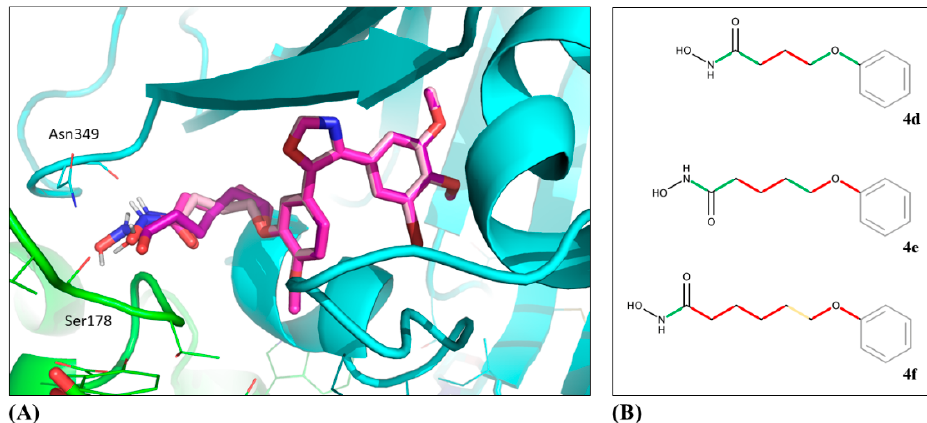
Figure 8. ( A ) Superposition of selected binding poses for 4d (light-pink), 4e (medium-pink) and 4f (dark-pink) in tubulin structure 5LYJ, exported from SeeSAR and visualized with PyMOL. ( B ) Illustration of frequent (green), occasional (yellow), and rare (red) torsions within the linker and hydroxamic acid group. Table 4. SeeSAR Docking results including estimated affinities (EA) and hydrogen bonds for Tubulin structure 5LYJ ordered by best estimated affinities. EA (SeeSAR) Hydrogen Bonds (SeeSAR)